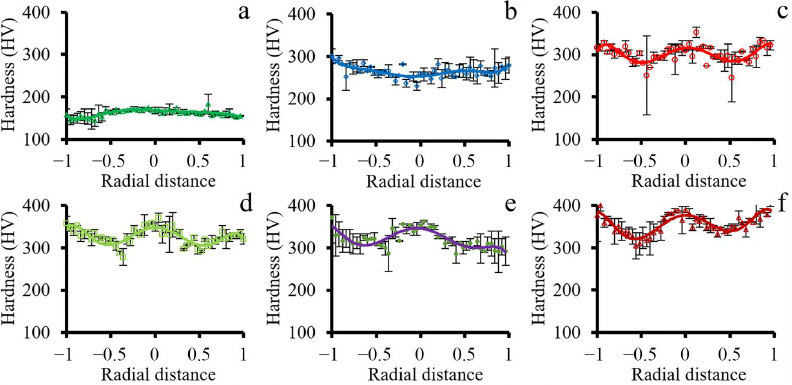
Figure 6. Vickers hardness distribution in the transverse cross-section in ( a ) the as-received condition and after a swaging reduction of ( b ) 20%, ( c ) 40%, ( d ) 60%, ( e ) 80%, and ( f ) 95%.